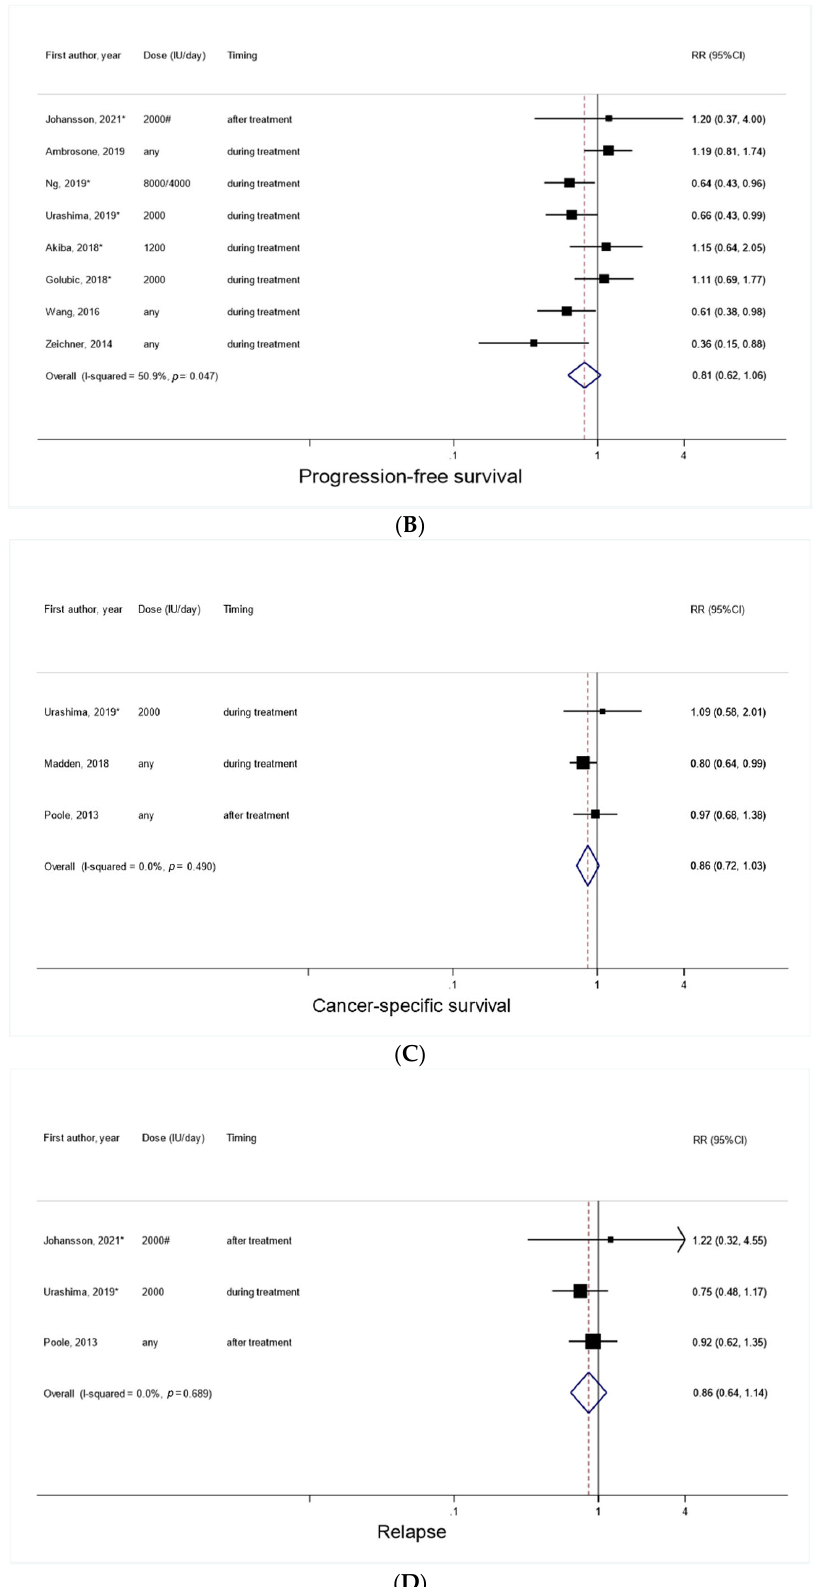
Figure 2. Forest plots for meta-analyses of post-diagnosis vitamin D supplement use and survival out- comes. ( A ) Overall survival; ( B ) Progression-free survival; ( C ) Cancer-specific survival; ( D ) Relapse. RCTs are marked with *. #: 100,000 IU/50 day, converted to 2000